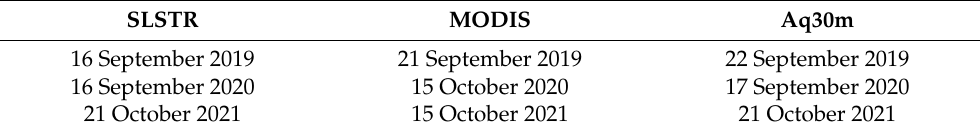
Table 2. SLSTR and MODIS image dates and Aq30m data. SLSTR MODIS